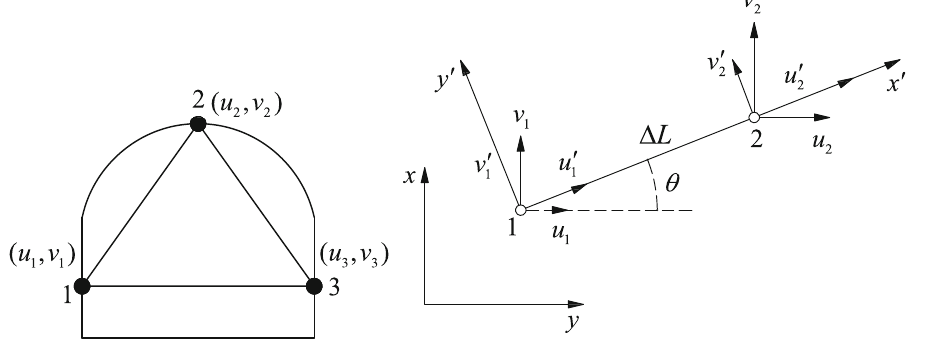
Fig. 14 Displacement components at two adjacent measuring points